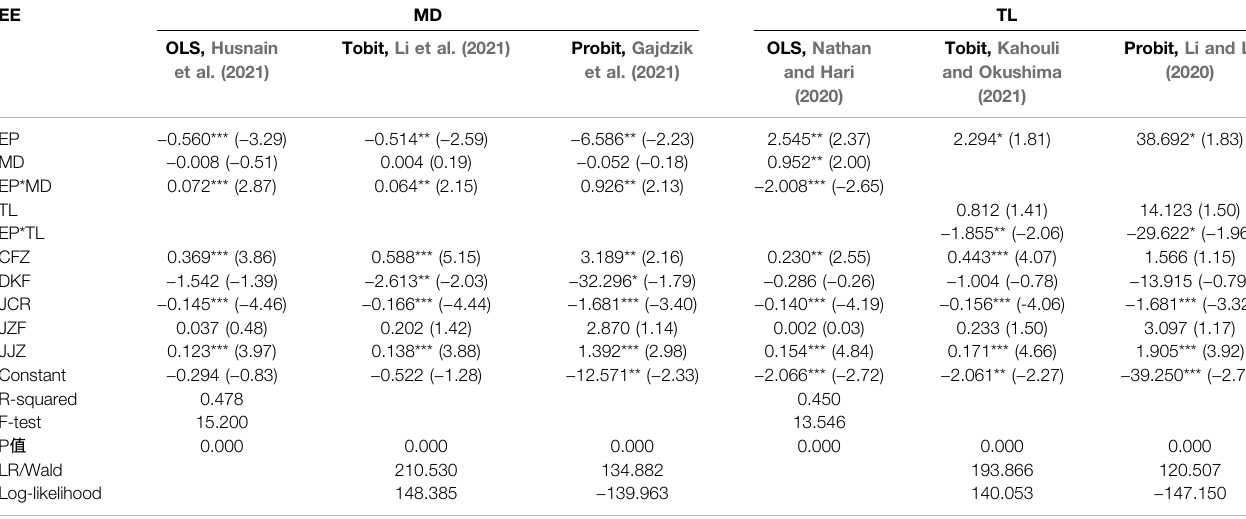
TABLE 7 | Regression results of adjustment effect of marketization degree and technology level.